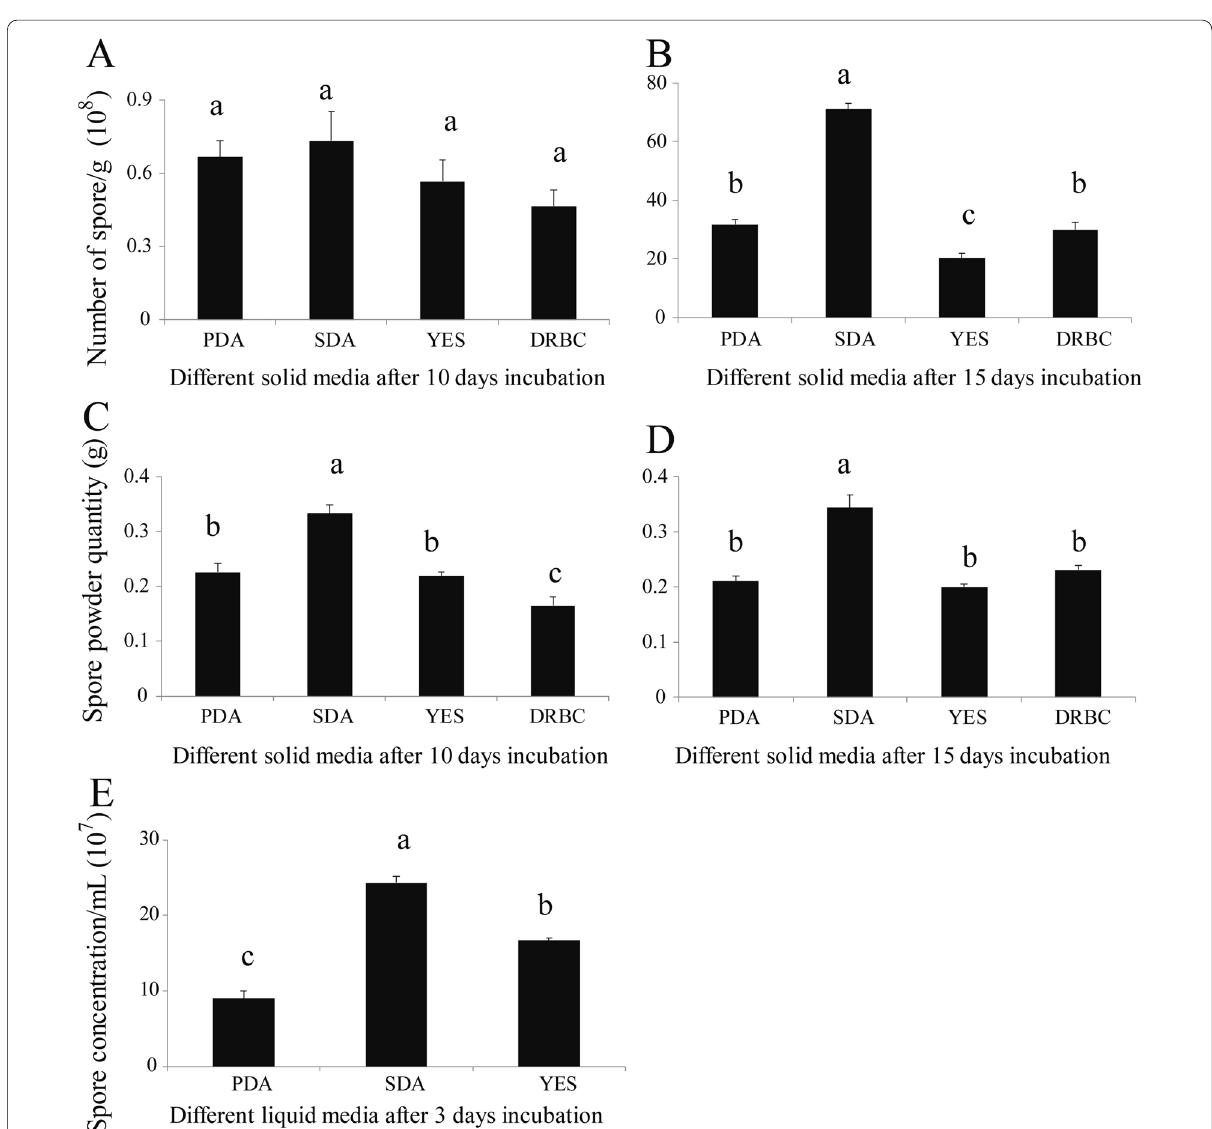
Fig. 2 Effects of various artificial media on sporulation of Beauveria bassiana. Bars with the same letters were not significantly in Duncan’s